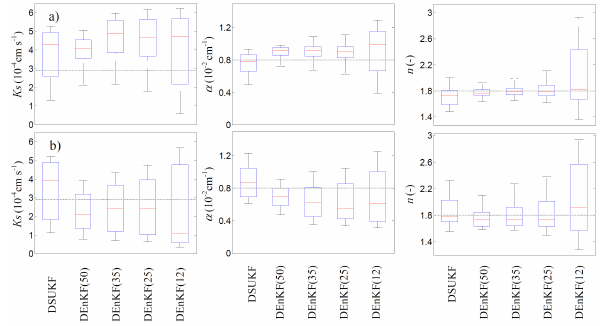
Figure 8. Box plots representing the posterior uncertainty of the parameters by performing DSUKF and DEnKF for 500 randomly chosen sets of initial parameters considering (a) the h - h (b) and θ - θ